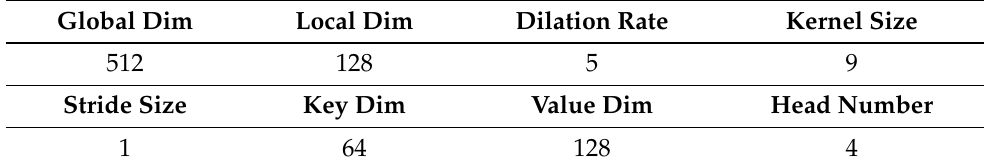
Table 1. parameters of